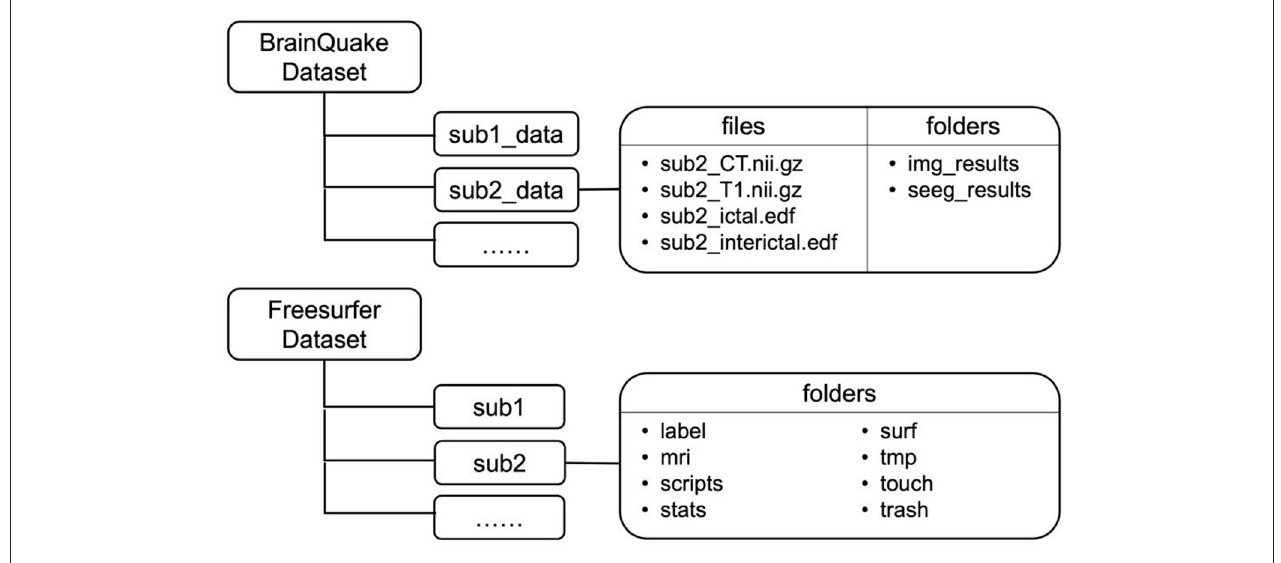
FIGURE 3 | File structures of two datasets implemented in BrainQuake. Temporary and final results are saved under the folders of each subject.